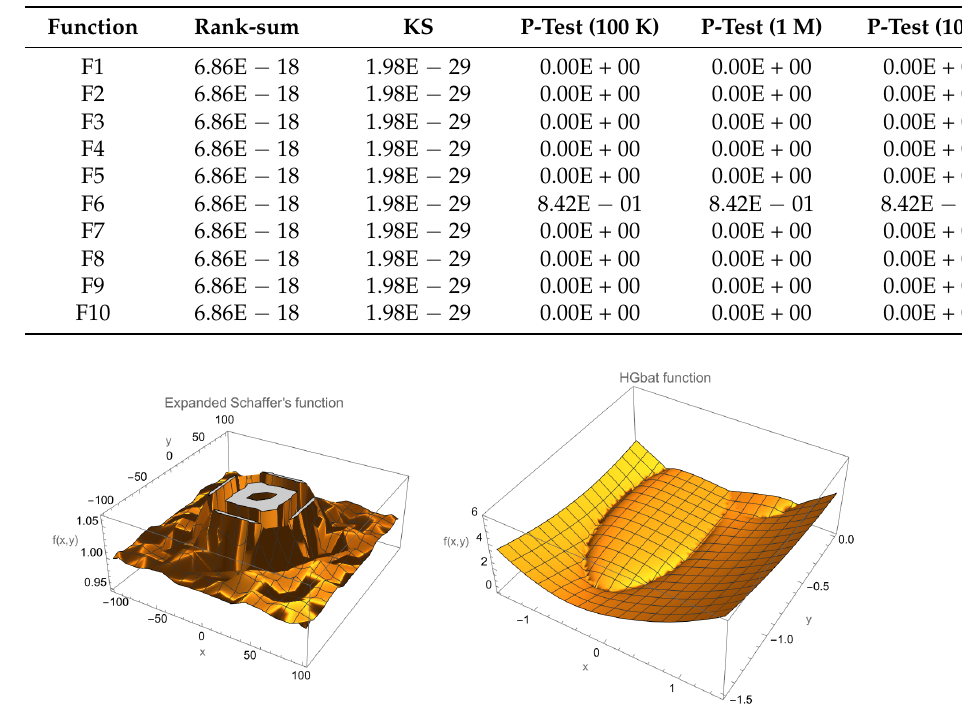
Table 11. The p -values obtained from Wilcoxon rank-sum, KS, and permutation tests when comparing SHADE and Jaya. When α = 0.05, the results for the tests are very consistent except for F6 where P-Test indicates no significant difference.